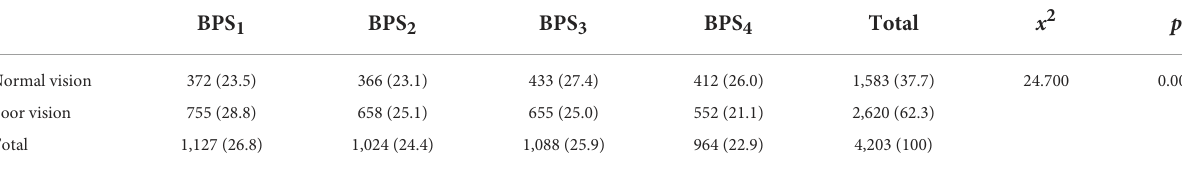
TABLE 18 Differences in the detection rate of poor vision in children and adolescents with different sedentary